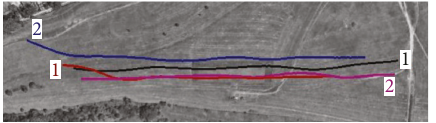
Figure 8: Almost straight close (1) and far (2) trajectories.